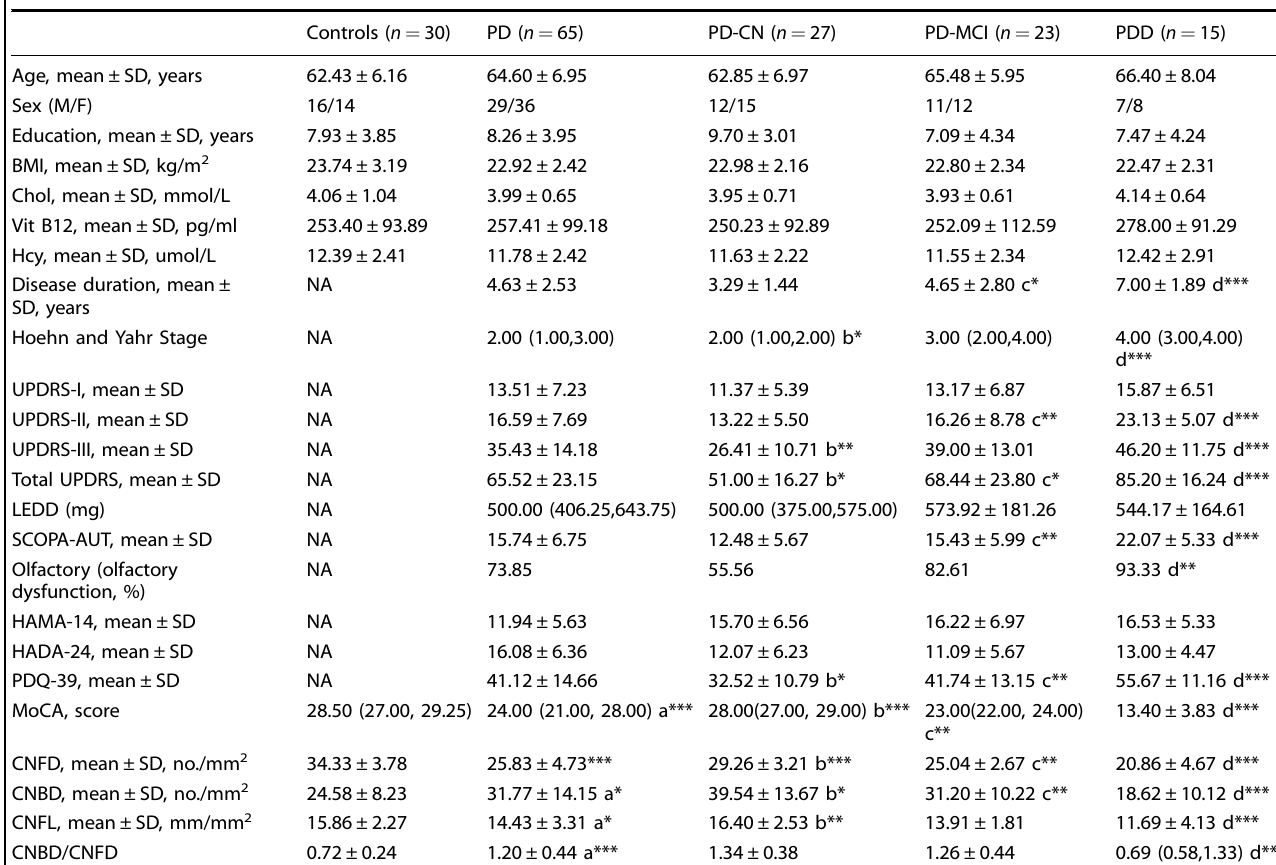
Table 1. Demographic characteristics of